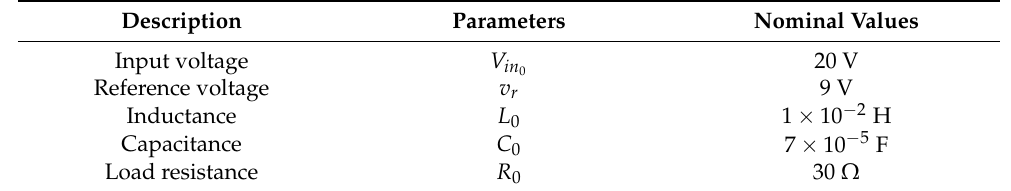
Table 1. Parameter values of the buck converter circuit.